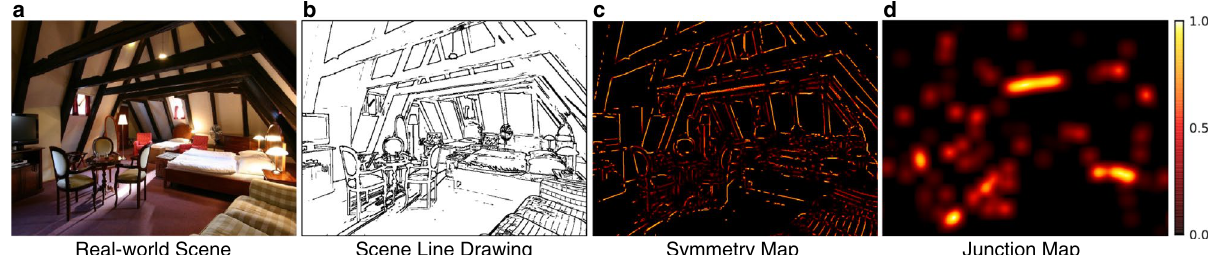
Figure 6. Scene, line drawing, and its corresponding symmetry and junction maps. Each scene ( a ) was first converted to a line drawing ( b ). Then, from the line drawing, local symmetry ( c ) and junction density were computed ( d ). The symmetry and junction maps served as mid-level feature maps in our